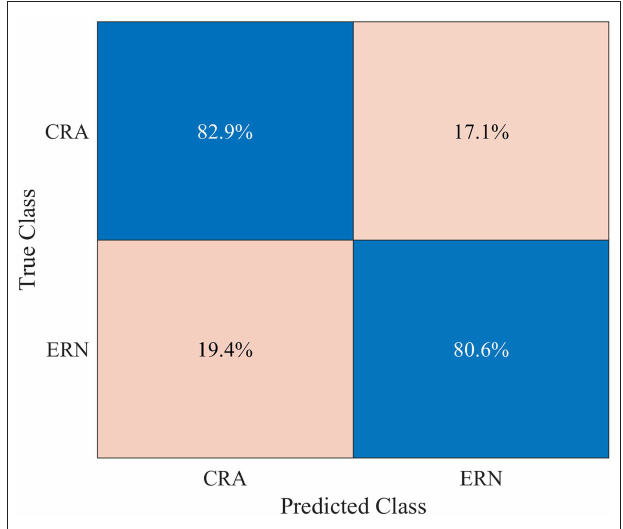
FIGURE 7 | Row-normalized confusion matrix for single-trial binary classification of error-related negativity (ERN) epochs against the correct-related activity (CRA) epochs, using 5-fold cross-validation.